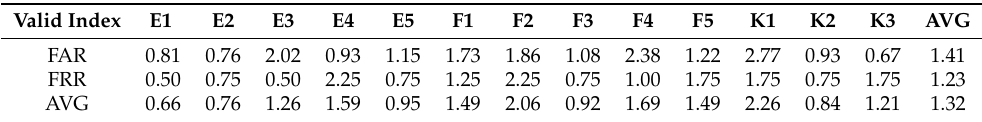
Table 18. Average FAR and FRR values obtained from proposed TCN-based DDP model for each pattern based on the Coordinate-A method (E, F, and K denote English, freestyle, and Korean patterns, respectively, and AVG denotes average